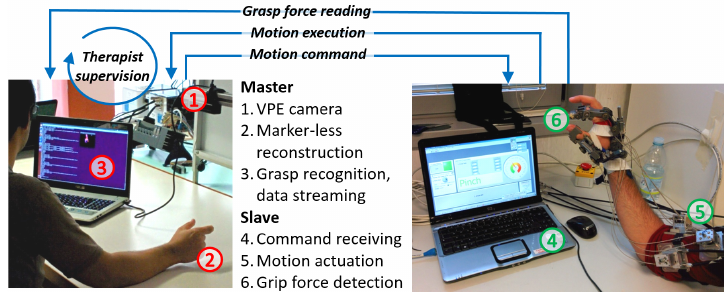
Figure 5. Our experimental setup provides an RT communication link, a natural direct driving of the gesture, and an on-the-fly supervision method of the operator.